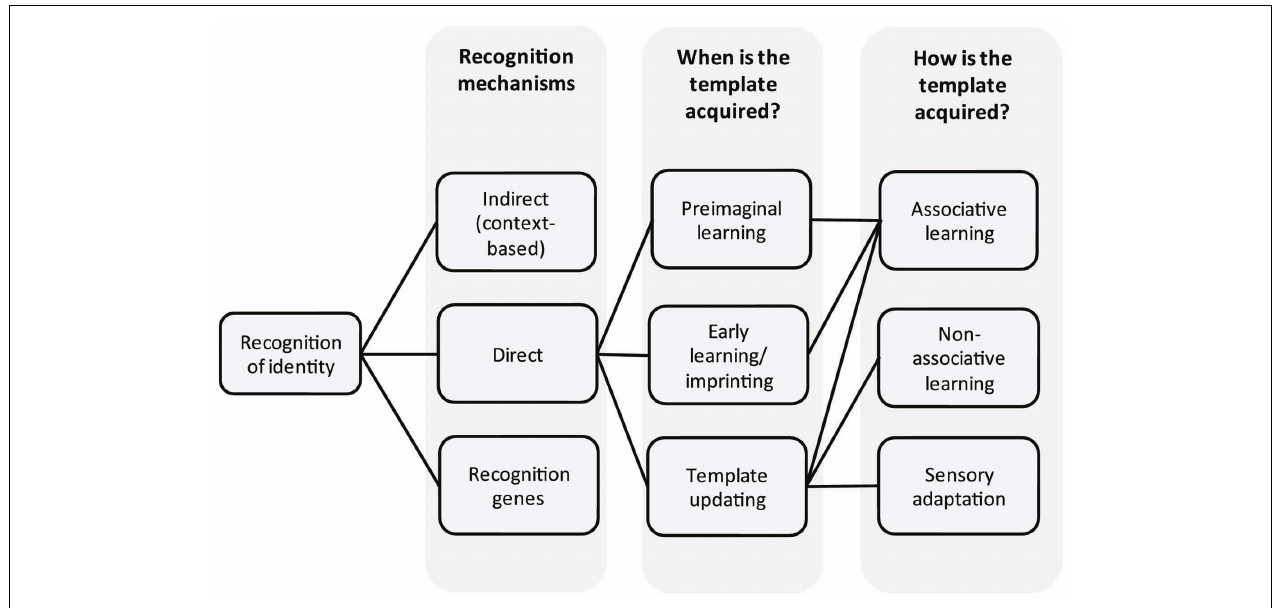
FIGURE 1 | Overview. Recognition of identity and underlying mechanisms as discussed in the text.